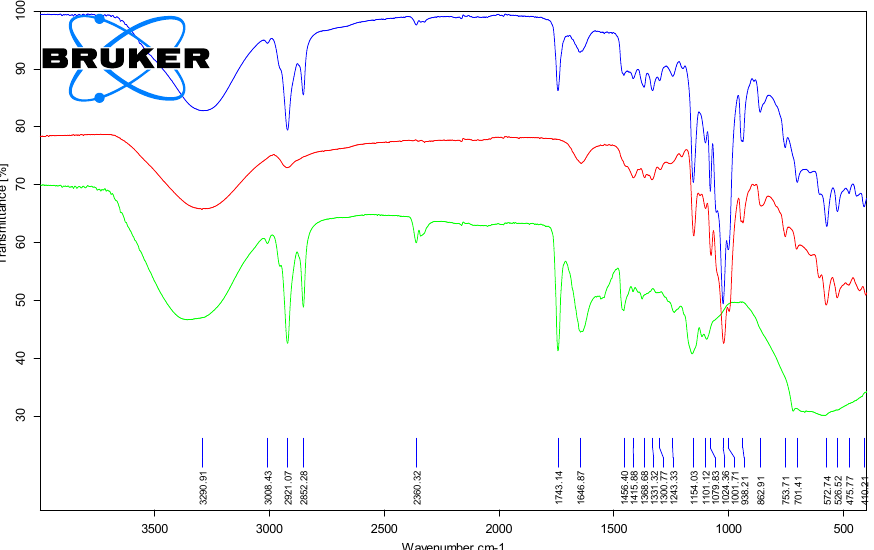
Figure 5. Superimposed ATR-FTIR spectra for the β-cyclodextrin/unprocessed chicken breast lipid complex (top—blue), β-cyclodextrin (middle—red) and lipid fraction from the unprocessed chicken breast (bottom—green) (duplicate samples “a”).